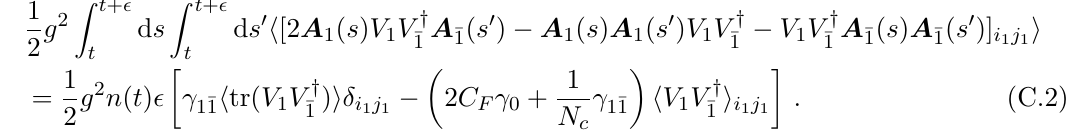
† † ] tr[ V ] tr[ V ] i and C V ¯1 V † ¯2 V 2 V ¯1 ¯2 1 2